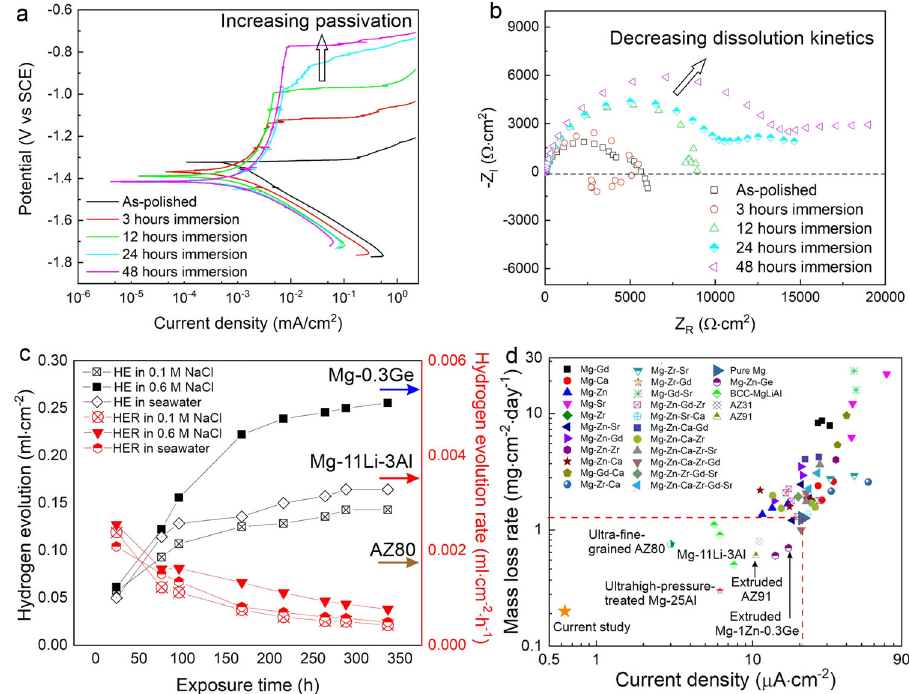
Fig. 2 Electrochemical chemical and immersion test. a potentiodynamic polarisation curves, b electrochemical impedance spectroscopy Nyquist plots of AZ111 alloy after immersion up to 48 h in 0.1 M NaCl electrolyte, c Accumulated hydrogen evolution (HE), and hydrogen evolution rate (HER) of the sample after 14 days immersion in 0.1 M and 0.6 M NaCl electrolyte, and seawater, d Comparison of the mass-loss rate and corrosion current density of AZ111 alloy with some typical Mg alloys in 0.1 M NaCl electrolyte 17,20,30 – 33 . Solid arrows in ( c ) show the hydrogen evolution rate of several corrosion-resistant Mg alloy, Mg-0.3Ge 23 , Mg-11Li-3Al 17 , and ultra- fi ne-grained AZ80 alloys 20 . Red dashed lines in ( d ) show mass-loss rate and corrosion current density of pure Mg as a benchmark 31